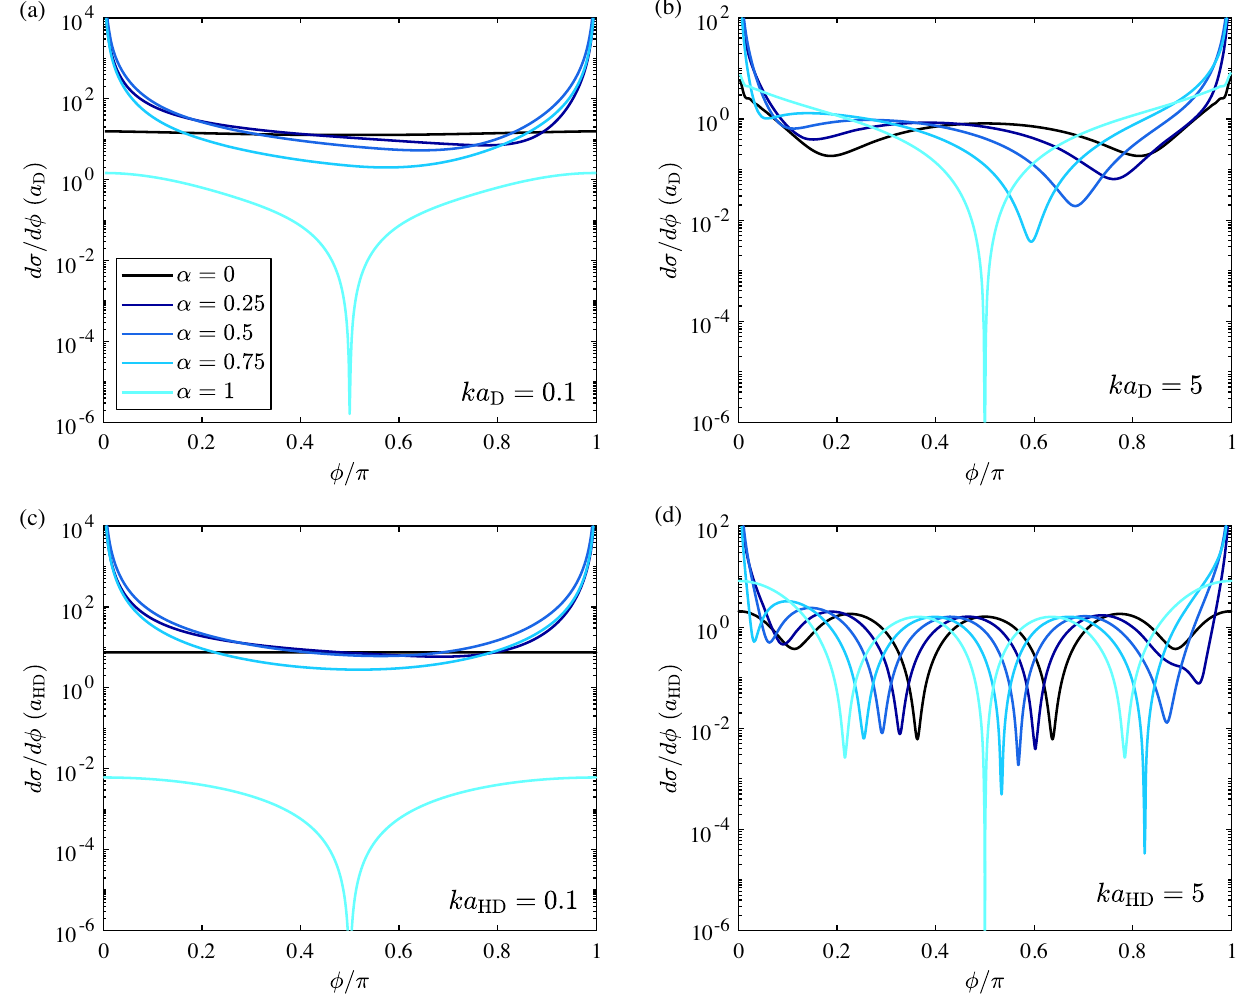
FIG. 6. Differential scattering cross section d σ =d ϕ as a function of the scattering angle ϕ for several values of the statistical parameter ν . The different panels refer to different values of the relative incident momentum k and different forms of the interaction potential V ii 0 . 1 , (b) dipolar interactions and ka 5 , (c) hard-disk interactions and between the impurities: (a) dipolar interactions and ka D ¼ D ¼ 0 . 1 , and (d) hard-disk interactions and ka 5 . The different curves refer to different values of the statistical parameter as ka HD ¼ HD ¼ indicated in the legend in panel (a): α ¼ 0 , 0.25, 0.5, 0.75 correspond to bosonic impurities at growing values of ν , while α ¼ 1 is the fermionic case with ν ¼ 0 . To avoid overcrowding the figure, no other curve for fermionic impurities is displayed. As it was shown in Fig. 5, such curves are immediately obtained from the bosonic ones via the symmetry relations in Eqs. (66) and